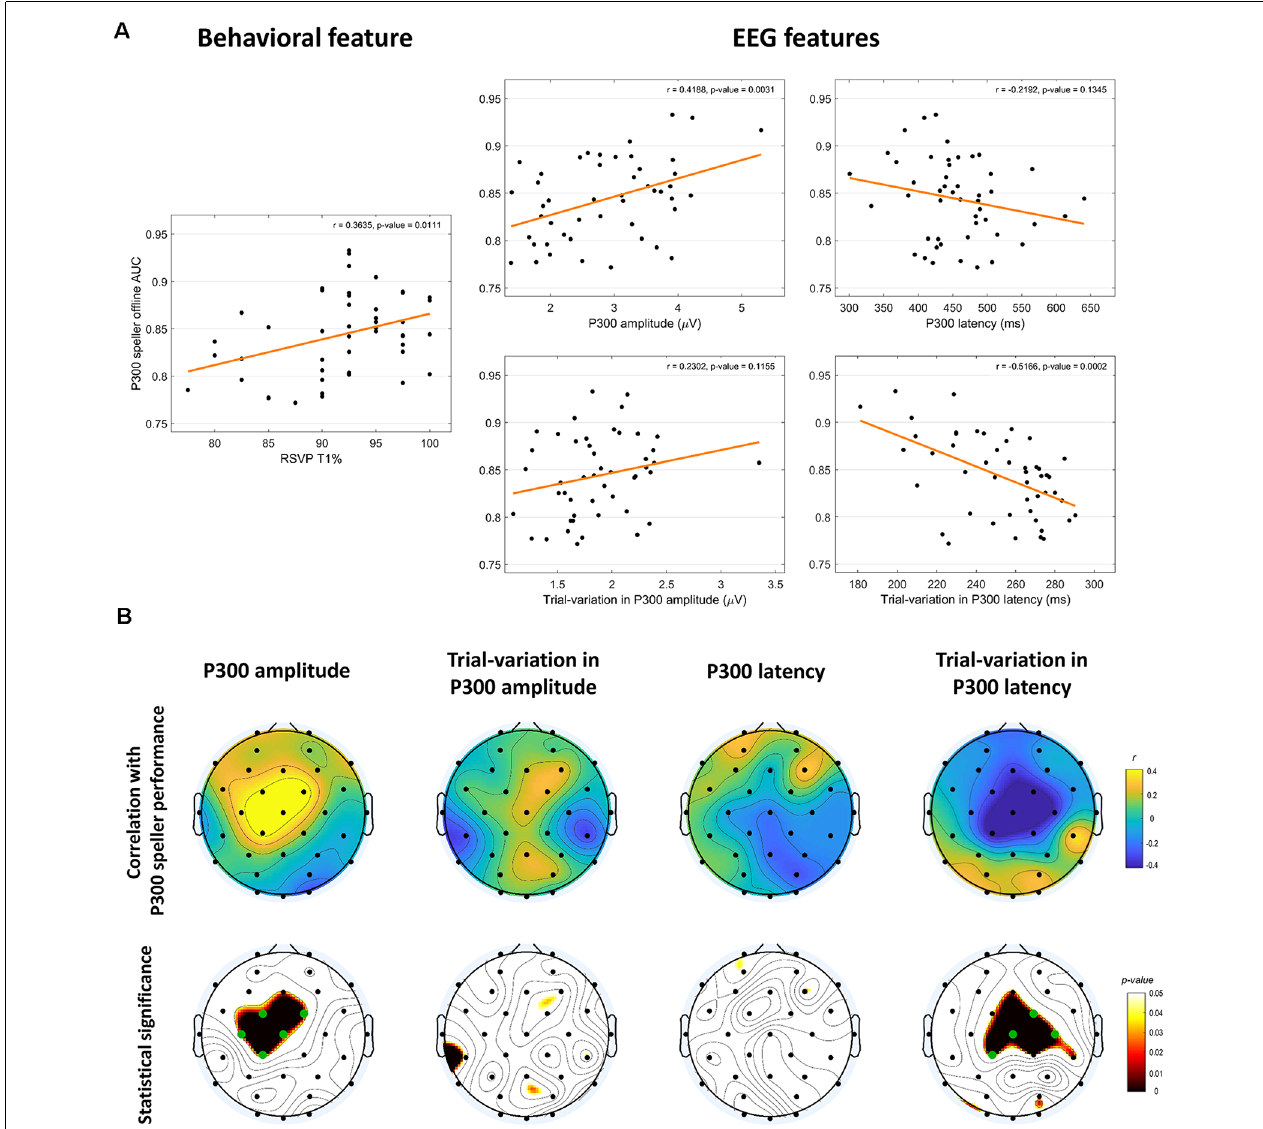
FIGURE 5 | Association with P300 speller performance. (A) Relationship between the various RSVP features and P300 speller performance using Pearson’s correlation coefficients and linear regression analysis. RSVP T1% is a behavioral feature and the others are RSVP EEG features. All except P300 latency and trial variation in P300 amplitude were correlated significantly with P300 speller performance. (B) The spatial patterns of the relationship between RSVP EEG features and P300 speller performance. Pearson’s correlation coefficients and their statistical significance (uncorrected p -values) are presented in the top and bottom row, respectively. The green dots in the scalp topography in the bottom row denote significant channels after